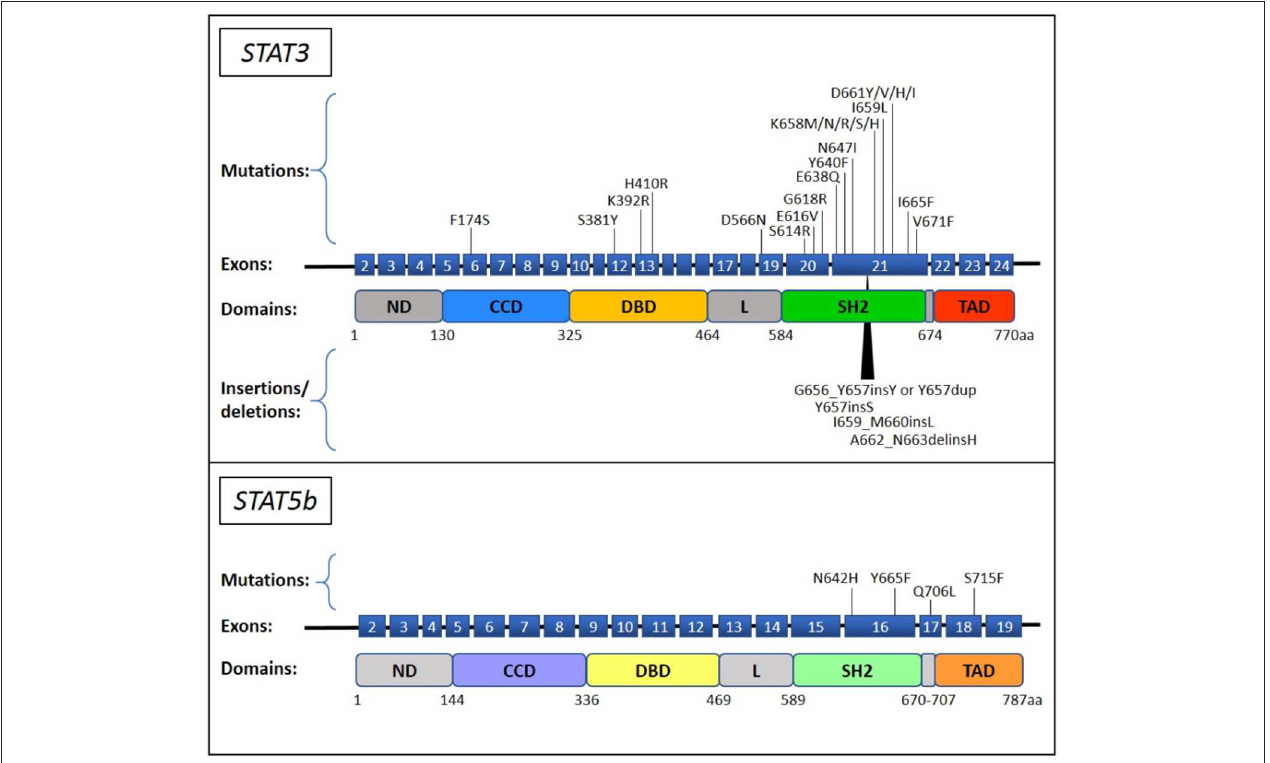
FIGURE 1 | STAT3 and STAT5b mutations described in T-LGLL and CLPD-NK. The STAT3 and STAT5b mutations, reported up to now in literature (13–32), are indicated on their position in the exon upstream the corresponding protein domain. The point mutations and the insertions/deletions are reported above and below the schematic representation of the gene, respectively. ND, N-terminal domain; CCD, coiled-coil domain; DBD, DNA binding domain; L, linker; SH2, Src Homology 2; TAD, transactivation